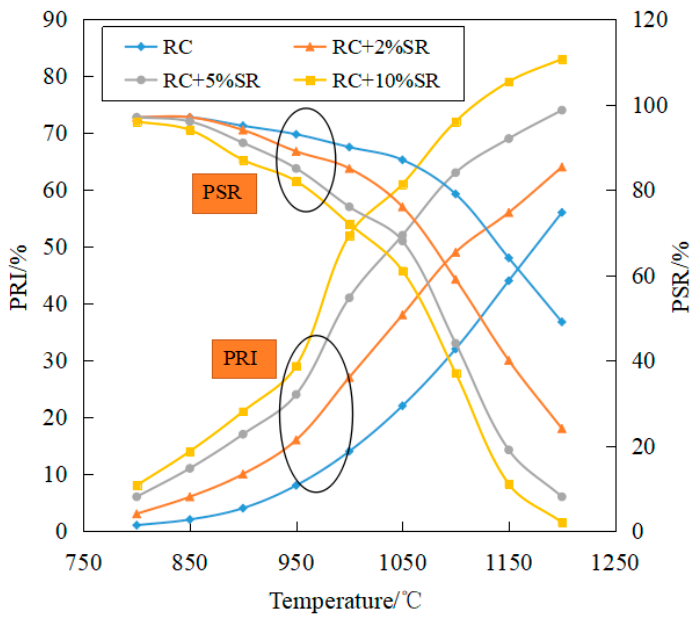
Figure 12. Thermal properties of four kinds of coke at different reaction temperatures.